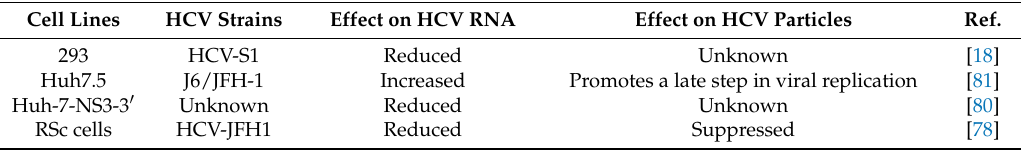
Table 2. The effects on HCV RNA and particles after the knockdown of DDX5 in different cell lines. Cell Lines HCV Strains Effect on HCV RNA Effect on HCV Particles